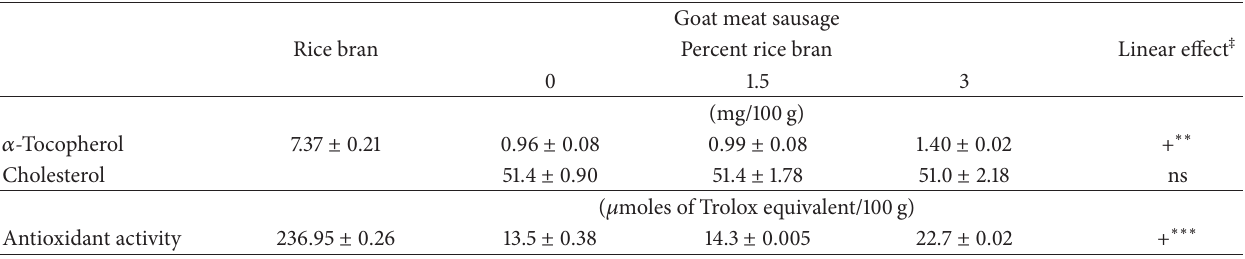
Table 4: 𝛼 -Tocopherol, cholesterol, and antioxidant activity of rice bran and cooked goat meat sausages with added rice bran (Means ± s.e.) § . Goat meat